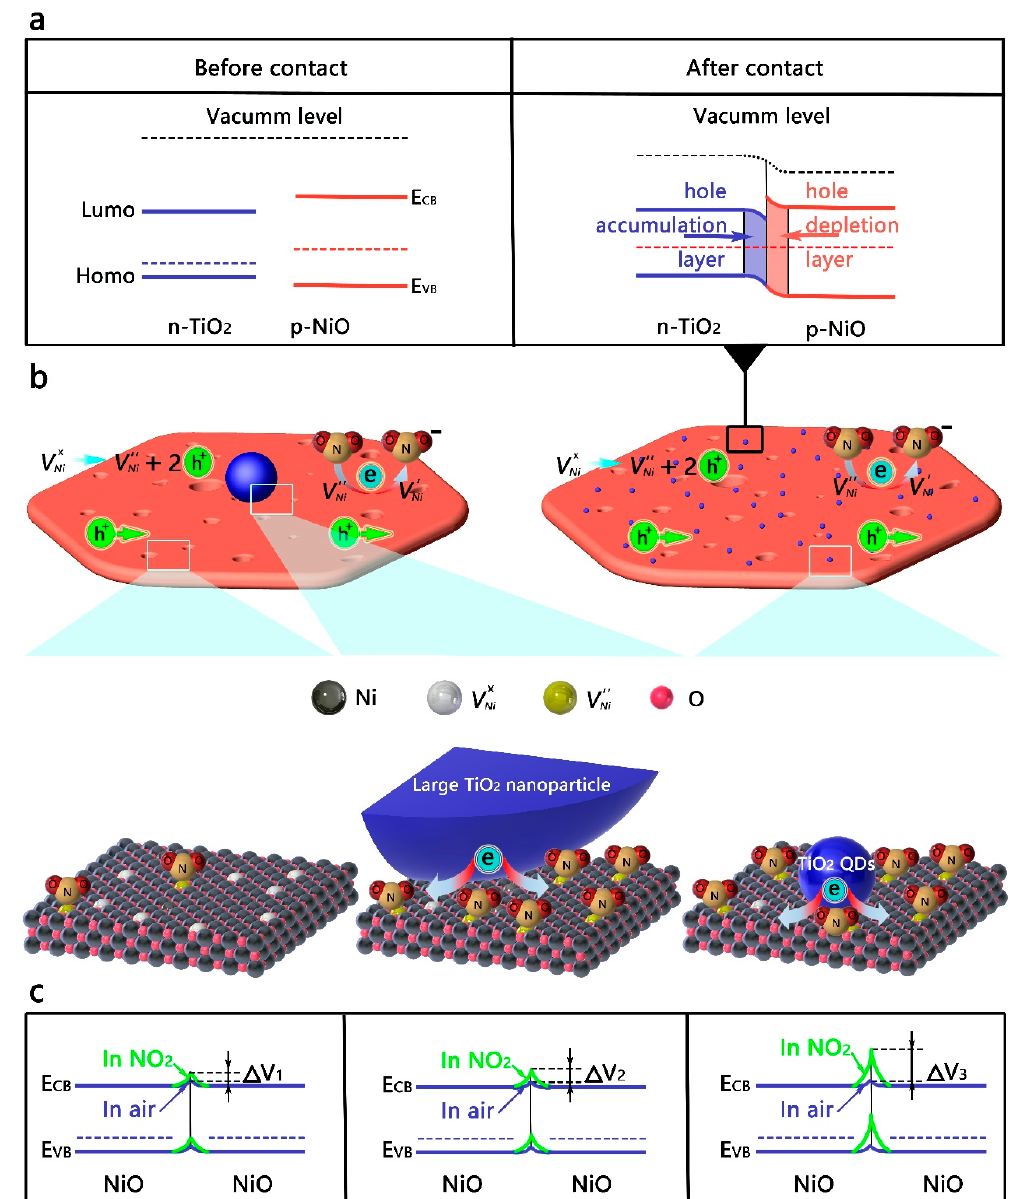
Figure 5. ( a ) The energy band diagram of the as-prepared samples, before and after contact. ( b ) The schematic of the interfacial interaction between the TiO 2 -NiO 2 nanohybrids structure and NO 2 molecules. ( c ) Comparison of the surface band bending between NiO nanosheets, large TiO 2 nanoparticle-modified NiO nanosheets, and TiO 2 QDs-modified NiO nanosheets.